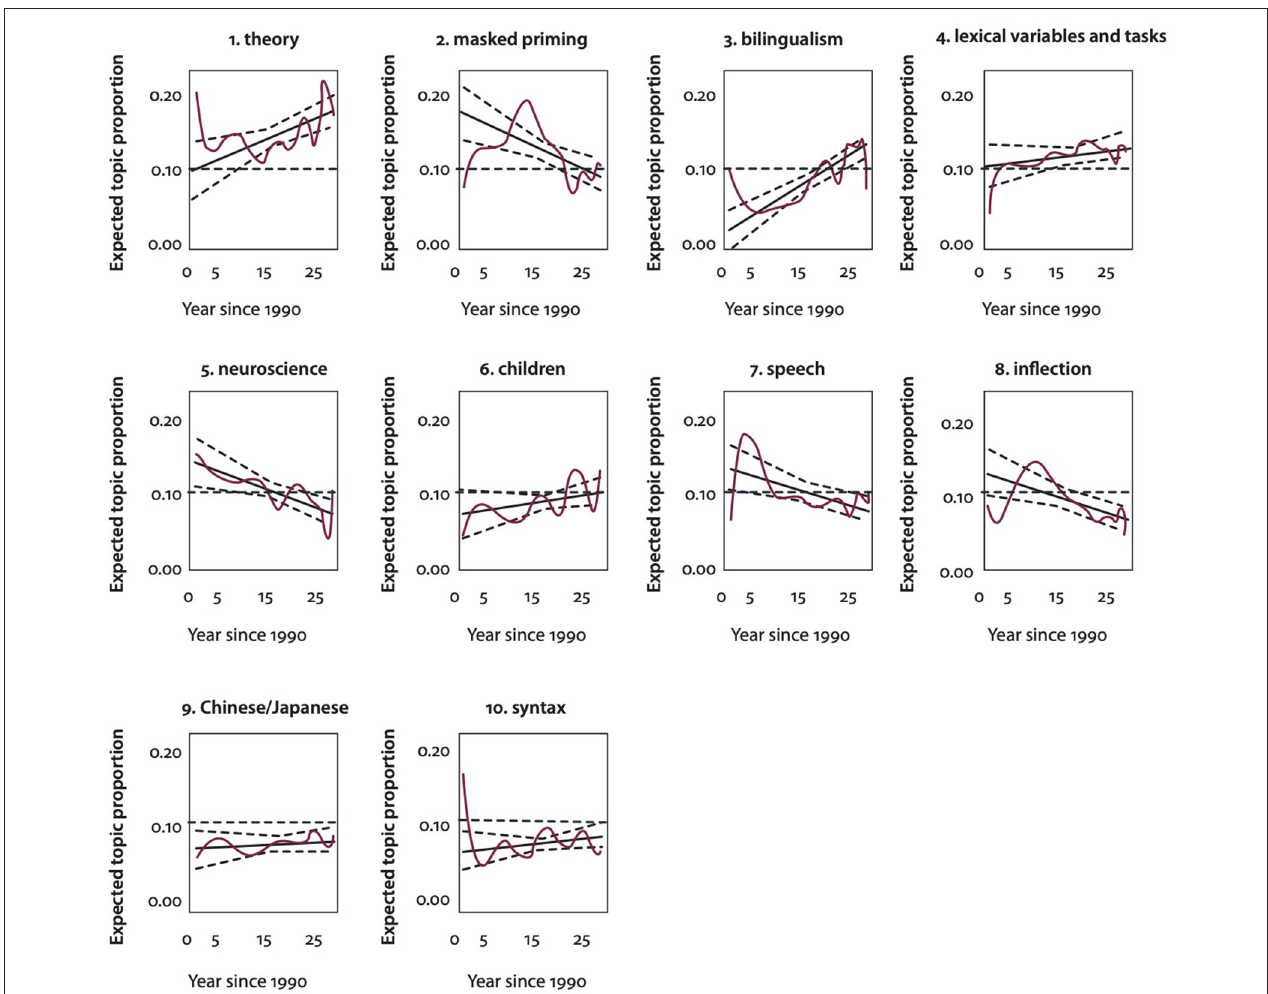
FIGURE 1 | Change in topic prevalence since 1990 reported in Kuperman et al. (2021). The non-linear fit is shown in red, the linear fit in black (dotted lines mark the 95% confidence interval). The horizontal (green) dotted line shows the default 10% of the topic. That would be expected over 10 topics. Source: From Kuperman et al. (2021)